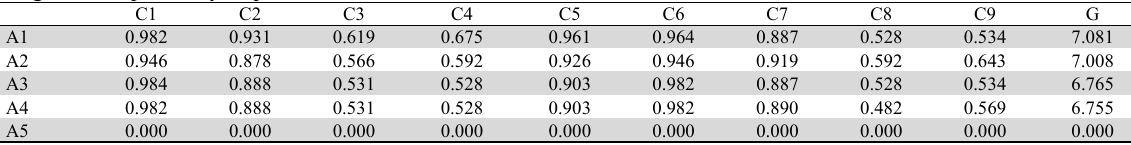
Weighted comparability sequence for the measures